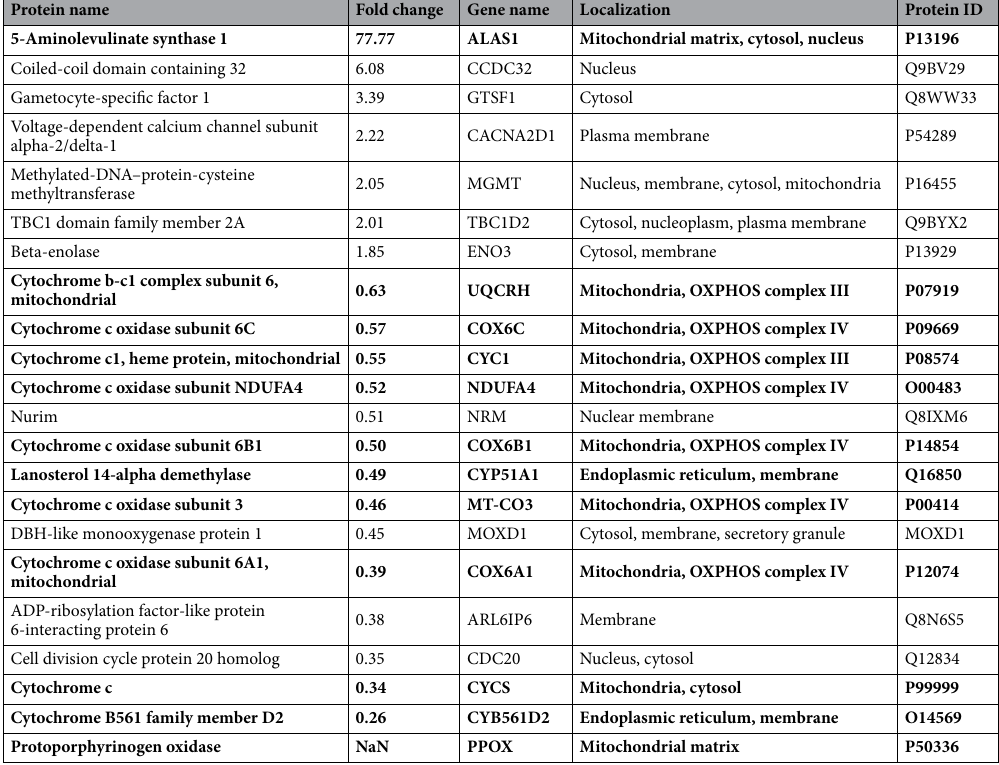
Table 2. List of significantly dysregulated proteins in PPO-KO cells. Value represents the fold change of the protein expression level relative to the control group. Heme-related proteins are shown in bold. NaN not a